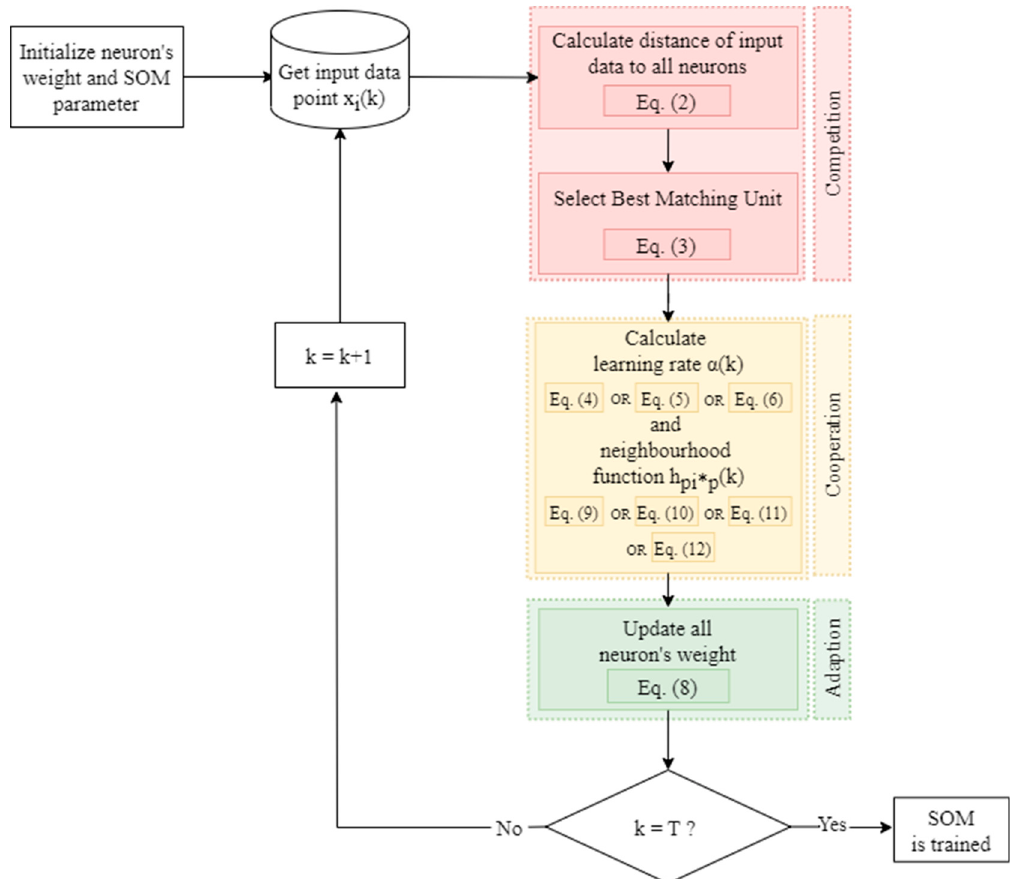
Figure 7. All steps of the SOM artificial neural network.